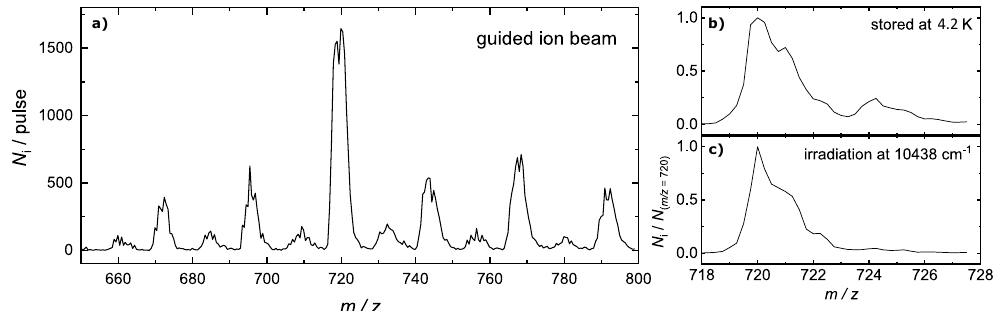
Figure 1. ( a ) Mass spectrum of positive ions generated by laser vaporisation of graphite. ( b ) Contents of trap following storage of C + ions in cold and dense helium buffer gas. ( c ) Mass spectrum obtained 60 following irradiation of stored ions at 10,438 cm − 1 , revealing dissociation of C +